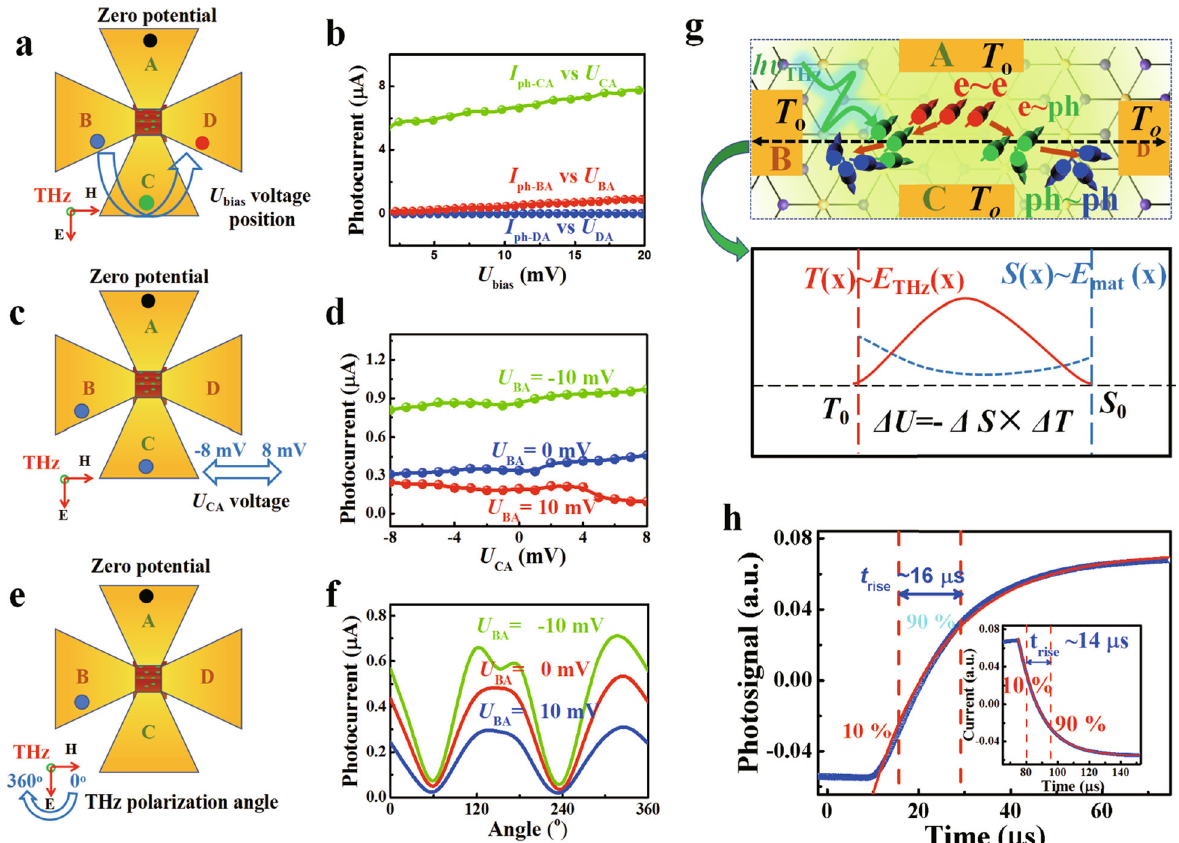
Fig. 3 Multi-dimensional controlling effects under 0.03 THz radiation. a , b Schematic and the photocurrents ( I ph-BA , I ph-CA , I ph-DA ) were measured under a sweeping voltage, U bias ( U BA , U CA , U DA ), from 0 mV to 20 mV at different electrode positions. c , d Schematic and the photocurrent ( I ph-BA ) was measured under a sweeping voltage, U CA , from − 8 mV to 8 mV at the same material orientation. e , f Schematic and the photocurrent ( I ph-BA ) measured under a sweeping THz polarization angle (0 o to 360 o ) at a certain voltage U BA ( − 10 mV, 0 mV and 10 mV). g Proposed non-equilibrium carriers ’ transport under electromagnetic radiation: T o is the reference temperature. Only the intraband free carrier (Drude) absorption can be generated at such a low-photon energy. T materials > T sink ~ T o , where T materials is the temperature of the fl akes, and T sink is the temperature of the metal sink. h Time-resolved photoresponse showing the deducted response time, τ rise/fall near 16 µs and 14 µs, with the fi tting function: exp (± t / τ